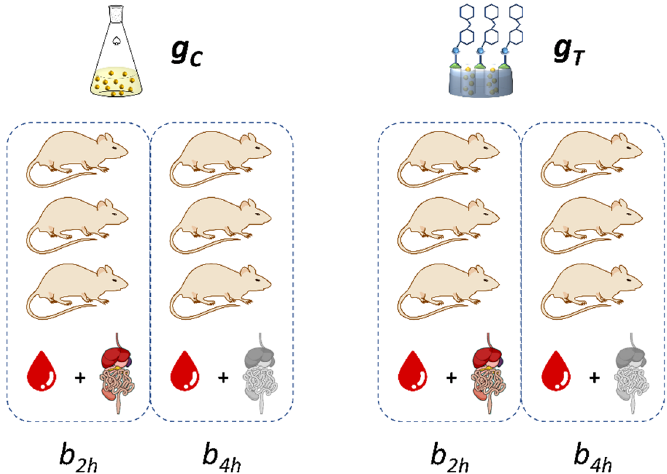
Scheme 3. Representation of the in vivo experiment’s design. Animals were divided into two groups, one for free- Cin administration as control ( g C ) and a second one for M41-Cin-L administration as trial group ( g T ). Additionally, both groups were subdivided into two batches, in which digestion assay was stopped after 2 h ( b 2h ), and a second group where the digestion was allowed to complete